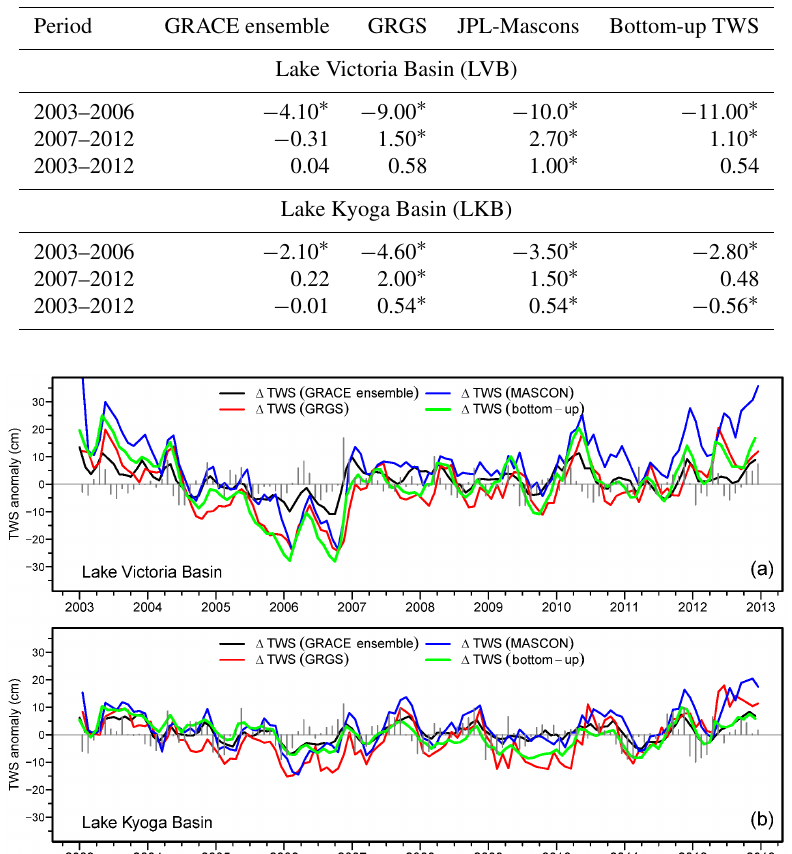
Table 3. Linear trends (cmyr − 1 ) in GRACE (cid:49) TWS and bottom-up (cid:49) TWS in the Lake Victoria Basin and Lake Kyoga Basin over various time periods (statistically significant trends; p values < 0.05 are marked by an asterisk).